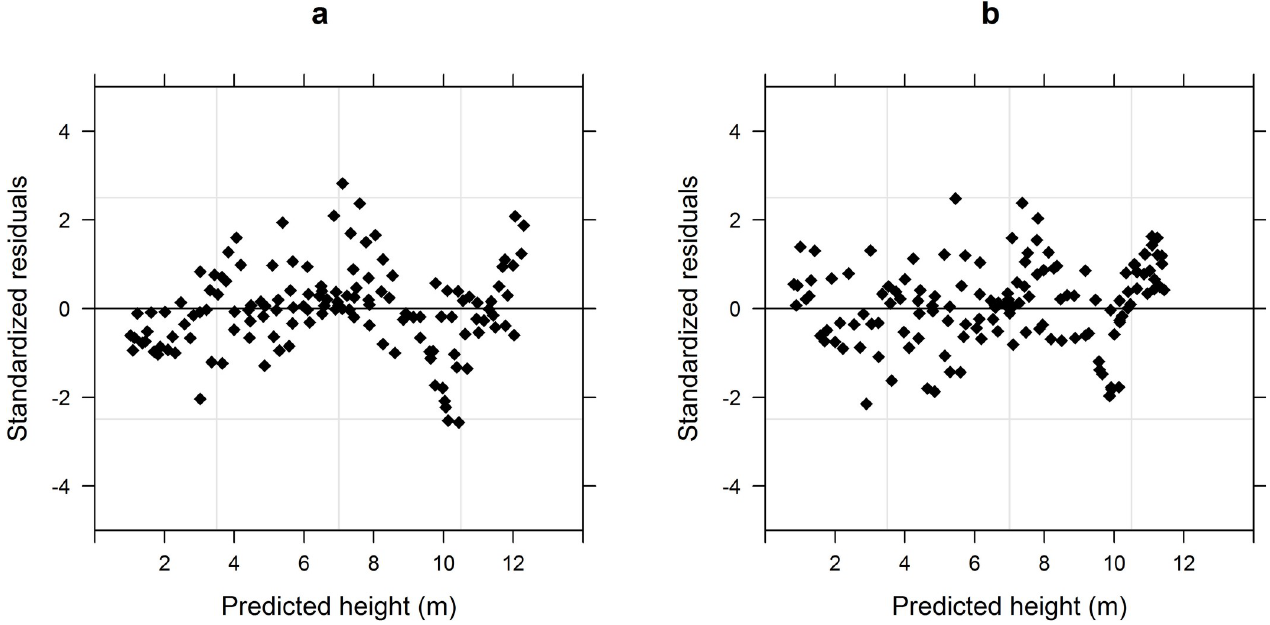
Fig 3. Distributions of standardized residuals of the mixed-effects model. (a) Without constant plus power variance. (b) With variance function.